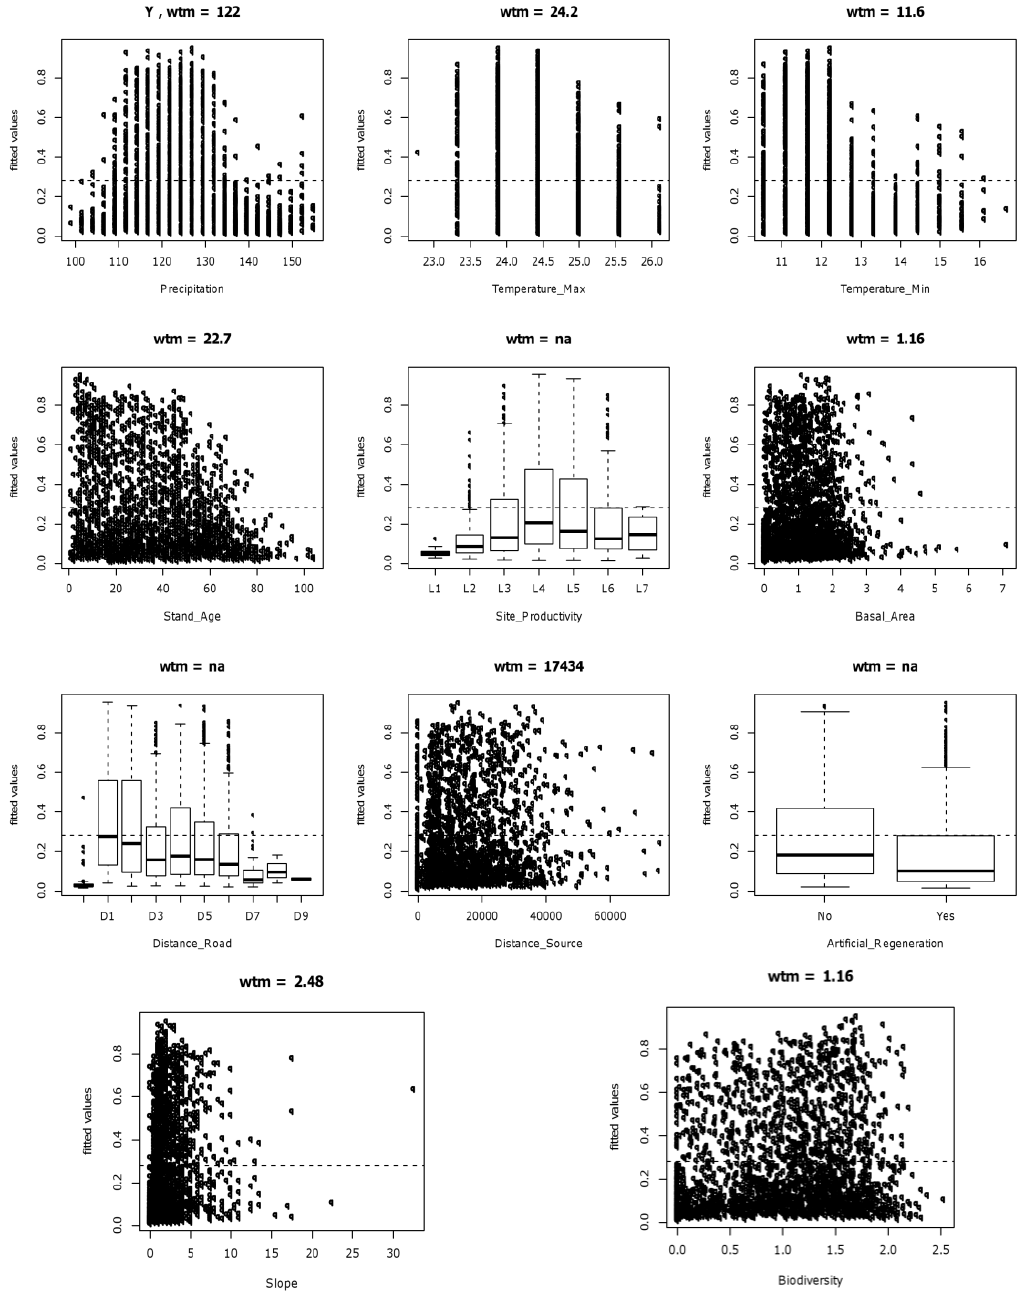
Figure 3. Fitted values plots for the explanatory variables included in the optimal boosted regression tree models for Japanese honeysuckle based on analyses of the 11 most influential variables. Values above each graph indicate the weighted mean of fitted values in relation to each non-factor explanatory variable.